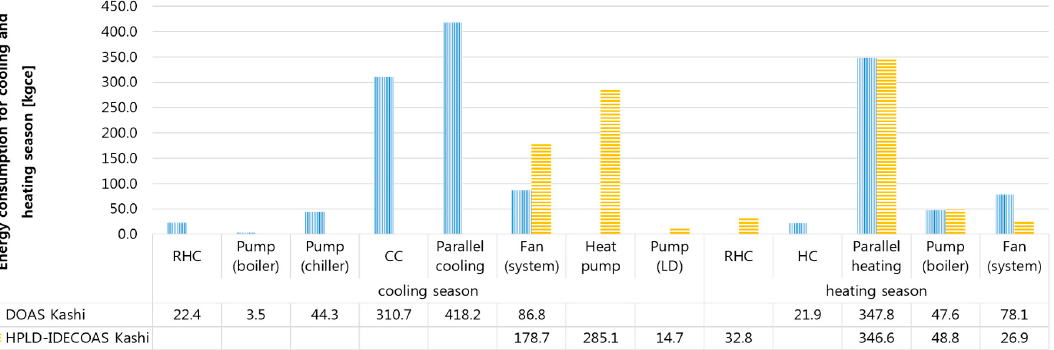
Figure 23. Comparison of seasonal energy consumption in Kashi.